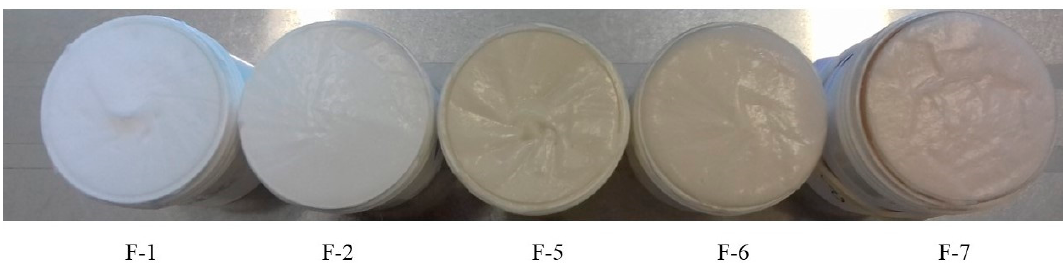
Figure 8. Macroscopic images: ointment base Lekobaza ® (F-1), Lekobaza ® with acetic acid solution (F-2), Lekobaza ® with acetic acid solution and ACTH 15 mg / g of ointment (F-5), Lekobaza ® with acetic acid solution and ACTH 20 mg / g of ointment (F-6), and Lekobaza ® with acetic acid solution and ACTH 25 mg / g of ointment (F-7).